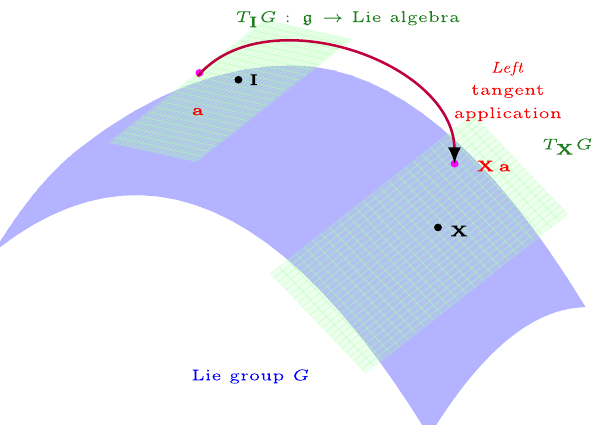
Figure 3. Geometrical relationship between T I G and T X G through the left tangent